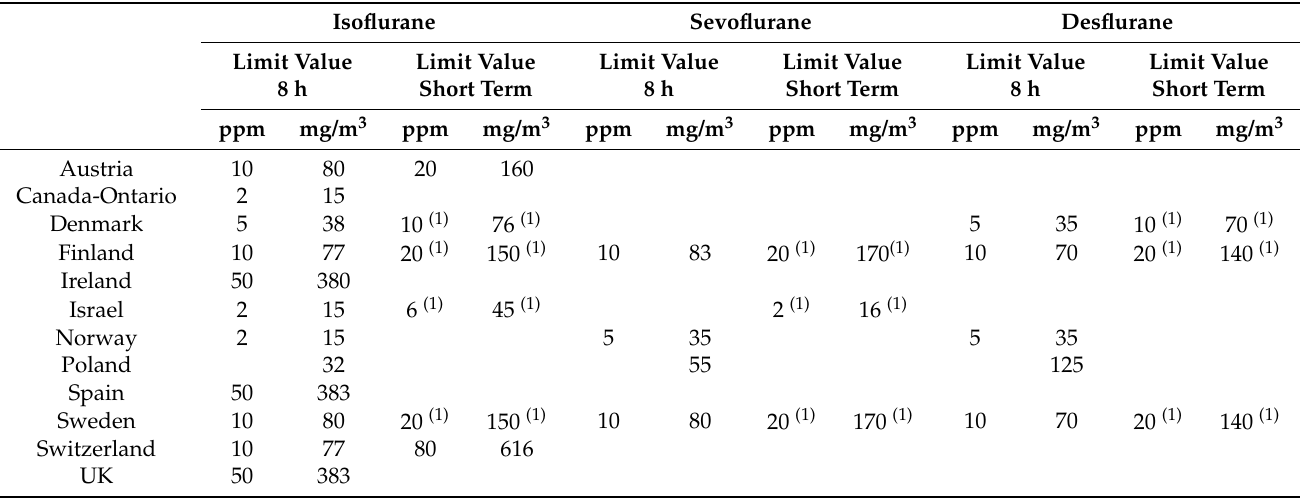
Table 1. Summary of national limit values for isoflurane, desflurane and sevoflurane useful for occupational exposure assessment. Isoflurane Sevoflurane